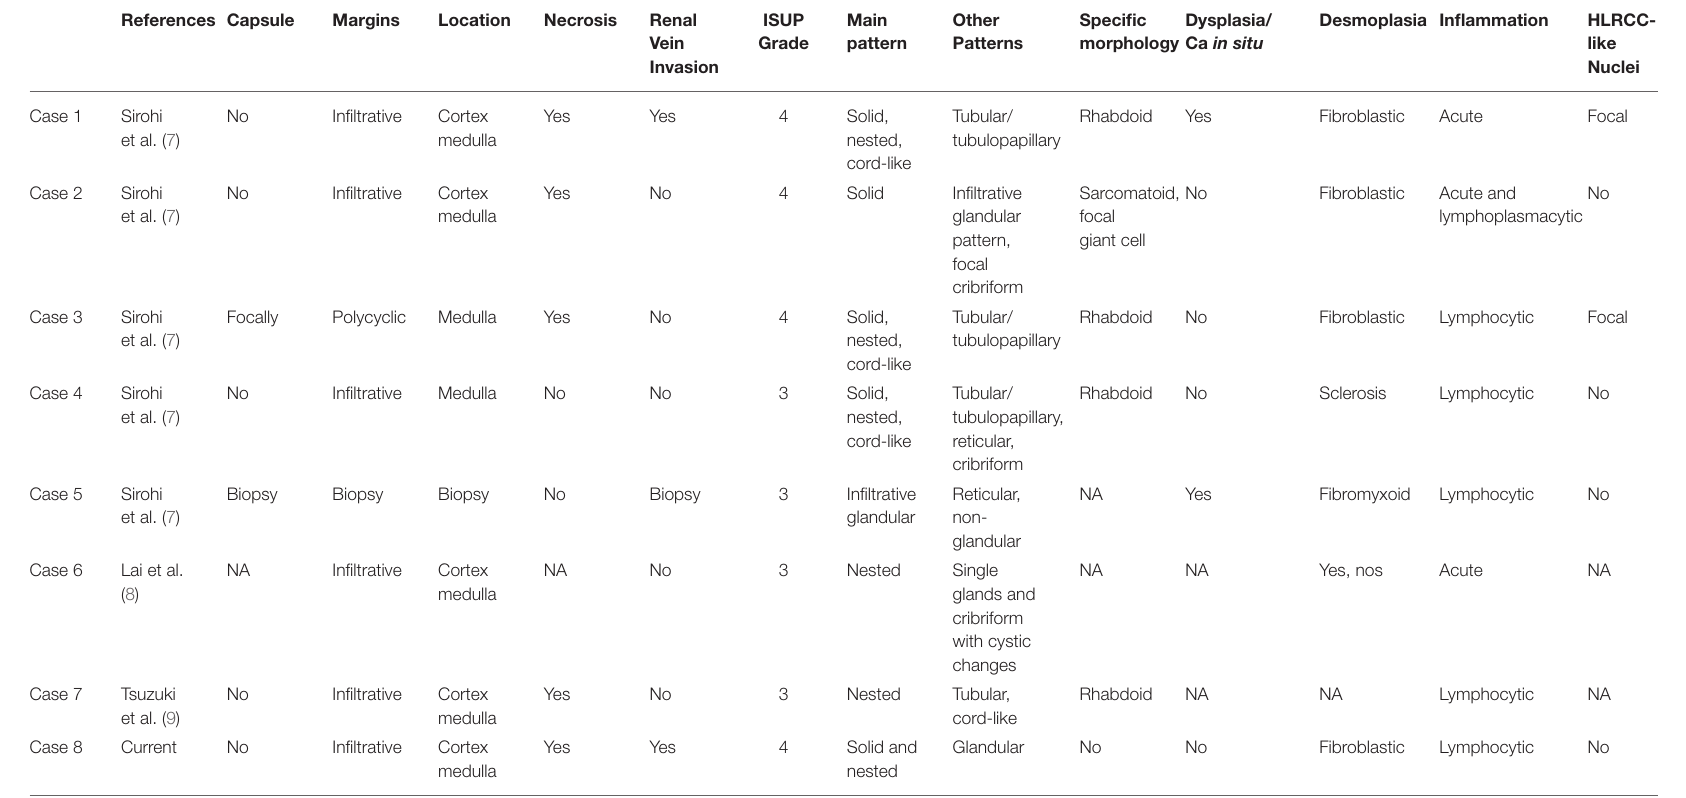
TABLE 2 | Morphologic